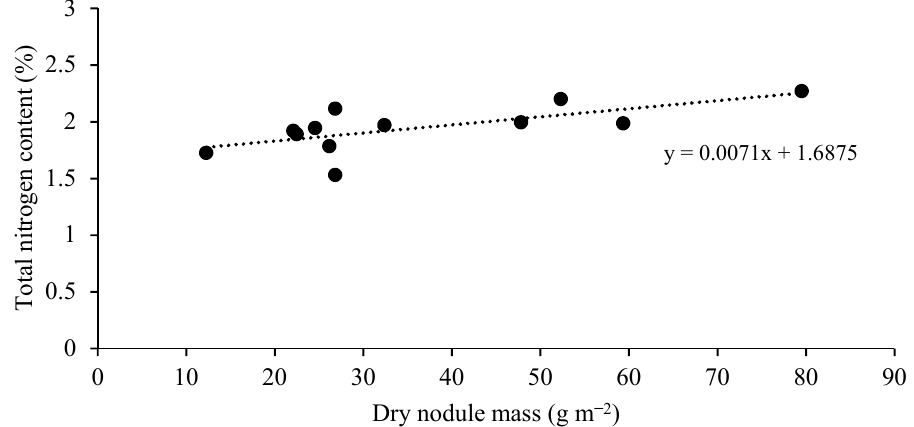
Figure 5. Linear correlation between total nitrogen content and dry nodule mass of the soybean roots.